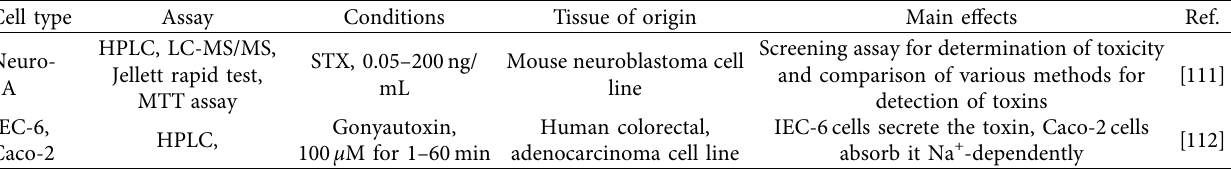
Table 11: Cytotoxicity of